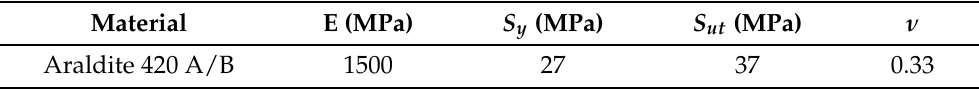
Table 2. Material properties of the structural adhesive